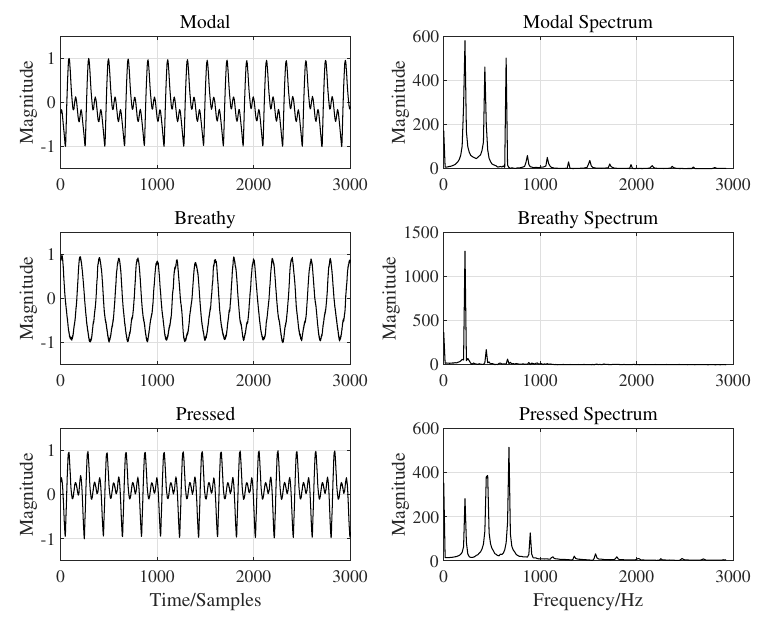
 H 1 H 2 H 3 H 4 ( a ) Harmonic quotients. ( b ) The SE, jitter and shimmer. Figure 5. The averages and standard deviations of H 1 – H 4 , SE, jitter and shimmer based on 31 participants’ “pure” NSA samples. The blue, red and green colours represent the modal, pressed and breathy voice types,